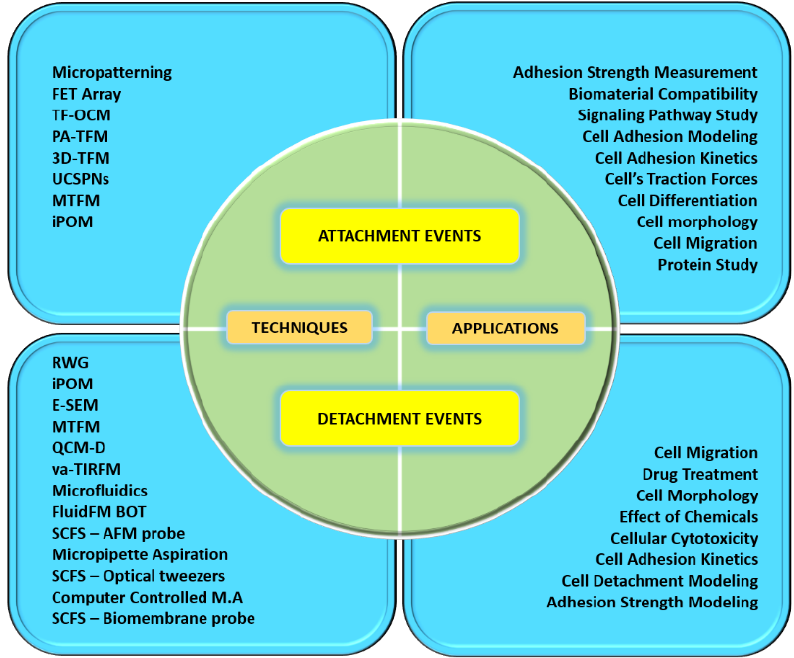
Figure 21. Summary of the techniques involved in single-cell adhesion studies categorized by the adhesion attachment and detachment events and their applications.